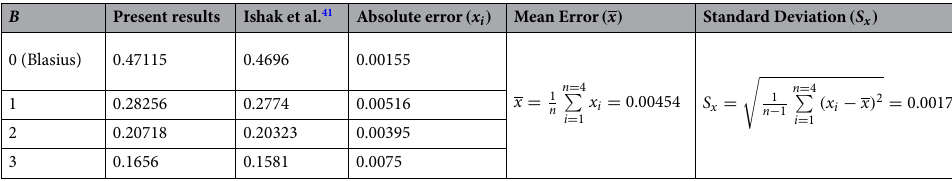
1 ) against Ishak et al. 41 (Fig. 1) corresponding with =